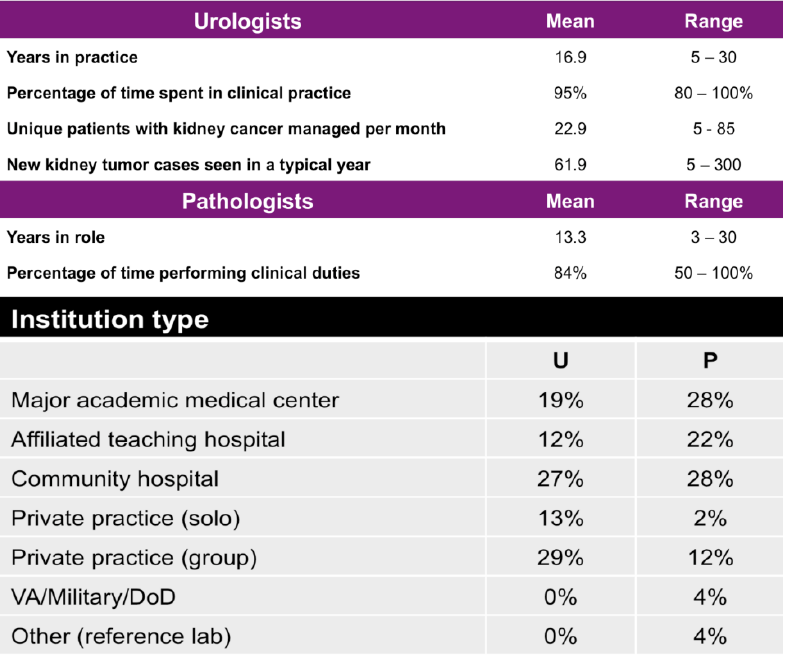
Table 2. Characteristics of Survey